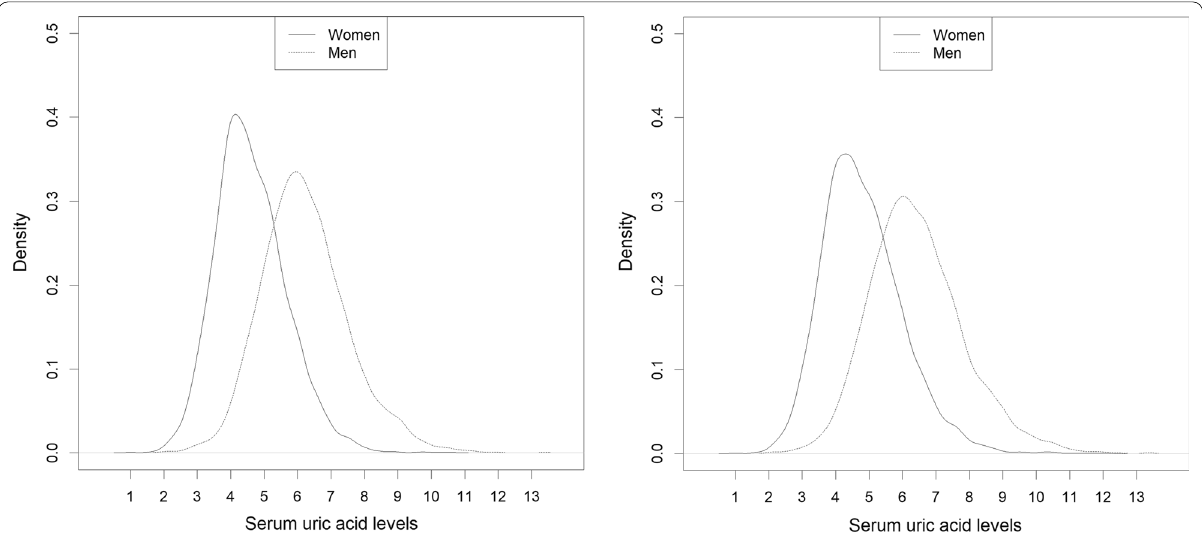
Fig. 1 Distribution of serum uric acid by sex in reference (left) and all sample (right) for men and